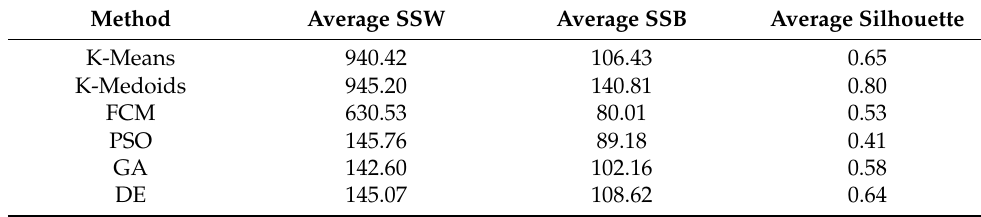
Table 10. Final Boundaries defined by FCM Procedure